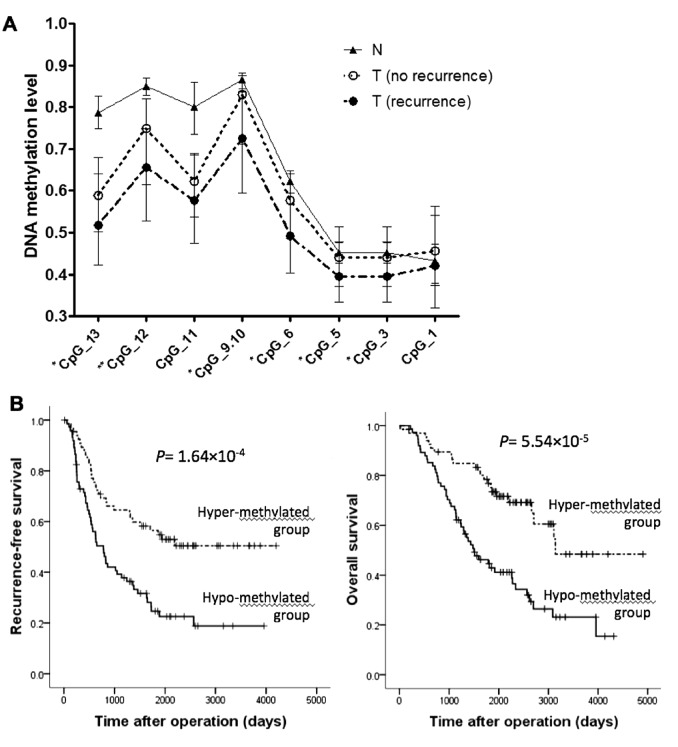
(A) Median DNA methylation levels of PTPRH in N and T with no recurrence and those with recurrence in LC-C2. DNA methylation levels of each CpG unit were evaluated quantitatively using the MassARRAY system. The error bars are defined by 25/75% quartiles. DNA methylation levels at most CpG sites showed a significant decrease in tumorous tissue with recurrence compared with those with no recurrence. Significantly different methylated CpG sites are marked as *P<0.05 and **P<0.01). (B) Kaplan-Meier survival curves of patients with PTPRH hypermethylation (>0.782 at CpG_9.10) and hypomethylation (≤0.782). The cutoff was determined by ROC curve analysis. The recurrence-free (P=1.64×10−4) and overall (P=5.54×10−5) survival rates of patients with hypomethylation were significantly lower compared to those of patients with hypermethylation (log-rank test). N, non-cancerous lung tissue; T, corresponding tumorous tissue; ROC, receiver operating characteristic.